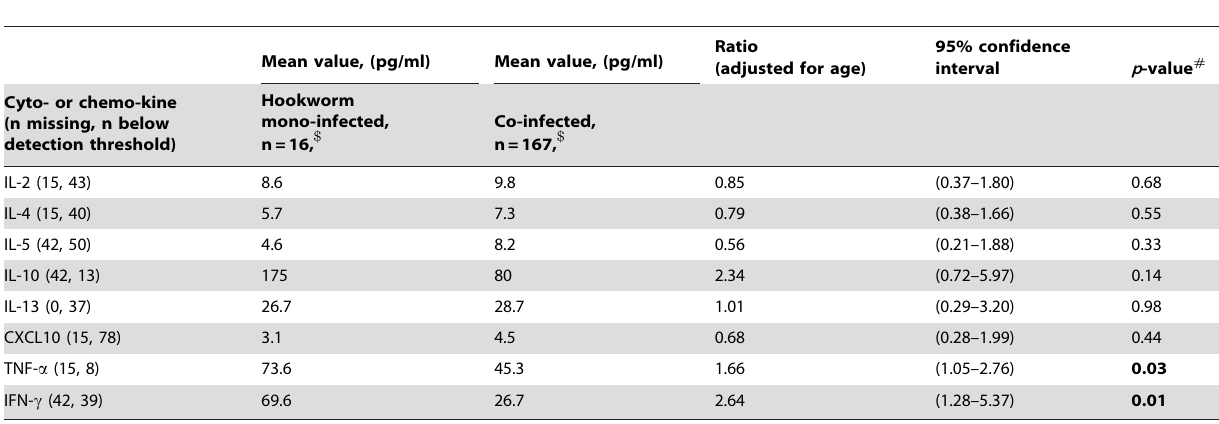
Table 7. ES antigen-induced cytokine and chemokine secretion in lymphocyte cultures from individuals mono- or co-infected with